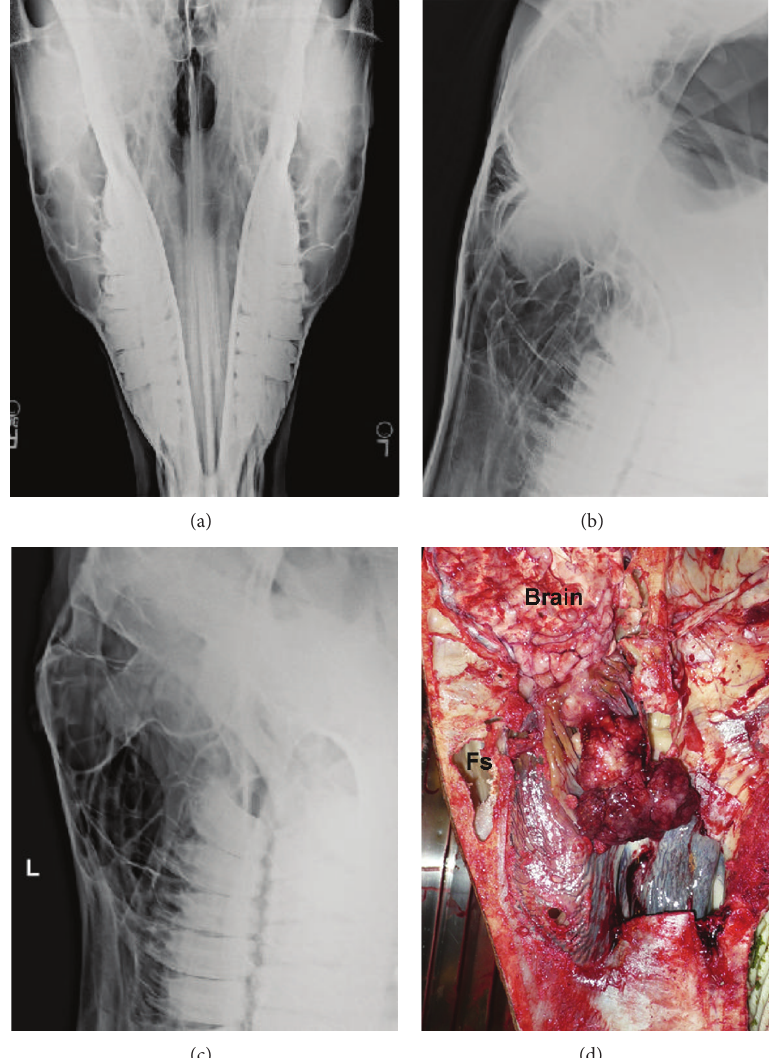
Figure 2: Radiographs of the skull at the time of second presentation in (a) dorsoventral and (b) lateral views. An indistinct soft tissue attenuating area is summating with the left turbinate region rostral to the rostral border of the choanae. (c) Oblique radiographic view of the left frontal and maxillary area. An indistinct soft tissue attenuating area is noted summating with the left lateral aspect of the ethmoid area. (d) Photographic image of the skull cut open in a left parasagittal plane. A dark red to tan mass is noted in the left ethmoid region attached to the caudal aspect of the turbinates. The mass does not extend through the cribriform plate. Fs: frontal sinus.